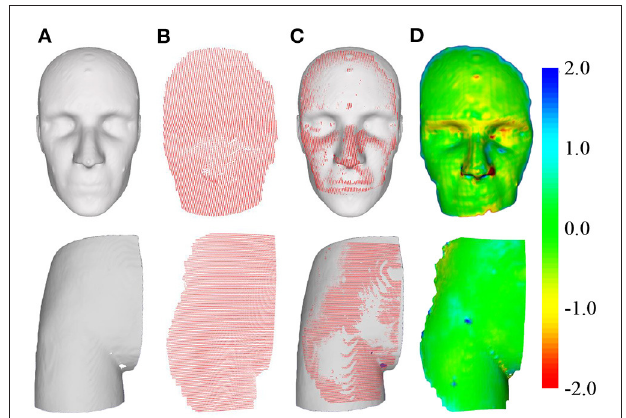
FIGURE 10 | Schematic of pointset registration. The top row is the head phantom, and the bottom row is the hip phantom. (A) Surface of the phantom extracted from CT. (B) Surface of the phantom captured by the 3D scanner. (C) Pointset overlay diagram after registration. (D) Distance map of the overlapped area after